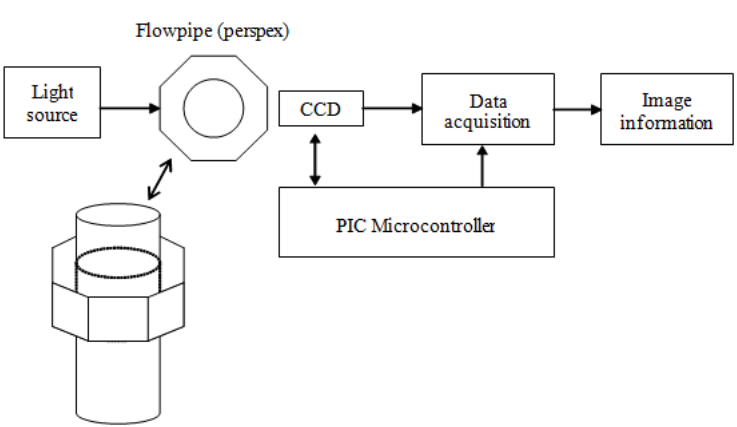
Figure 2. A block diagram of the optical tomography